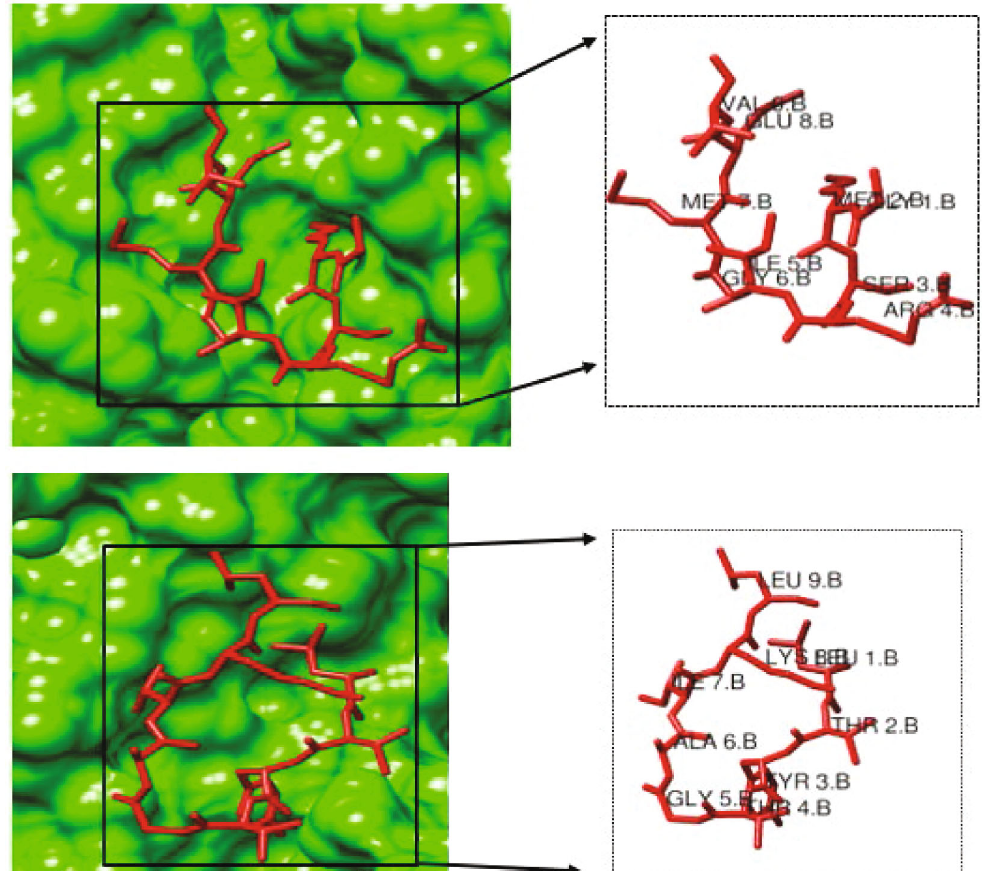
Figure 5: Molecular docking of the peptides GMSRIGMEV and LTYTGAIKL and the HLA A0201 molecule. GMSRIGMEV had binding free energy of -8.3kcal/mol and -10.0 kcal/mol for LTYTGAIKL.